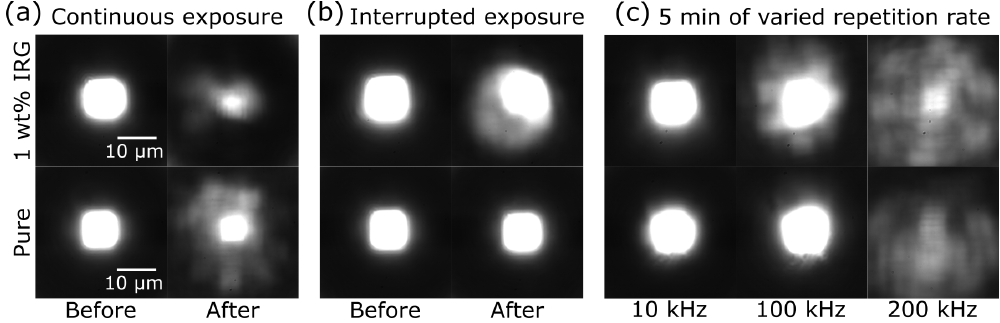
Figure 8. Focusing performance of microlenses after exposure to I p = 1.27 GW/cm 2 515 nm 300 fs radiation in continuous ( a ) and multi-burst mode: 10 s exposure followed by a 10 s pause ( b ); ( c ) lateral distribution at the focus of microlenses exposed to 5 min of continuous radiation at I p = 1.91 GW/cm 2 (515 nm 300 fs) achieved with repetition rates of 10, 100 and 200 kHz. The 10 kHz case also serves as a before image, as there were no changes in focusing properties after this